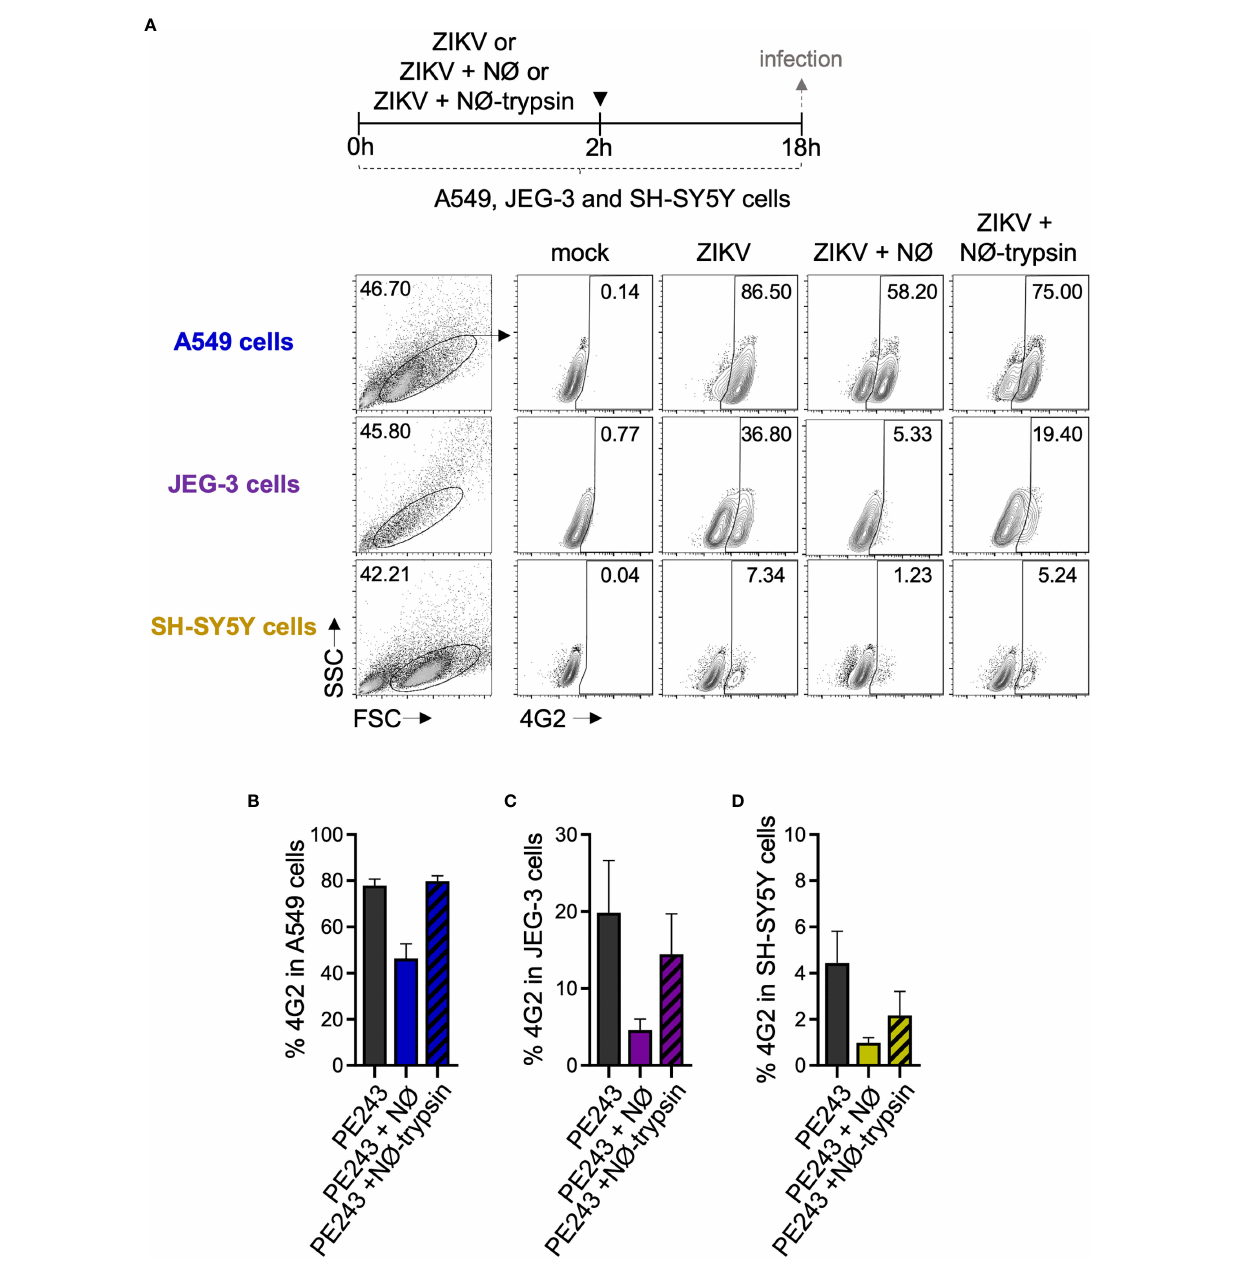
FIGURE 8 | Human neutrophils reduce ZIKV infection in different cell lines. (A) Flow cytometry plots depicting the frequency of 4G2 + A549 cells, JEG-3, and SH-SY5Y cells 18 hours post-infection with ZIKV PE243 (10 MOI). Cells were infected for 2 hours in the absence of neutrophils (ZIKV-PE243), presence of neutrophils (ZIKV-PE243 + NØ), or presence of trypsin pretreated neutrophils (ZIKV-PE243 + NØ-trypsin). After the wash steps, cells were maintained for additional 16 hours. Mock condition was used as a negative fl uorescence control. (B) Frequency of 4G2 + A549 cells 18 hours post-infection with ZIKV in the absence or presence of neutrophils. (C) Frequency of 4G2 + JEG-3 cells 18 hours post-infection with ZIKV in the absence or presence of neutrophils. (D) Frequency of 4G2 + SH-SY5Y cells 18 hours post-infection with ZIKV in the absence or presence of neutrophils. Bars indicate SEM. Two independent experiments are shown (n = 4 – 6). NØ,